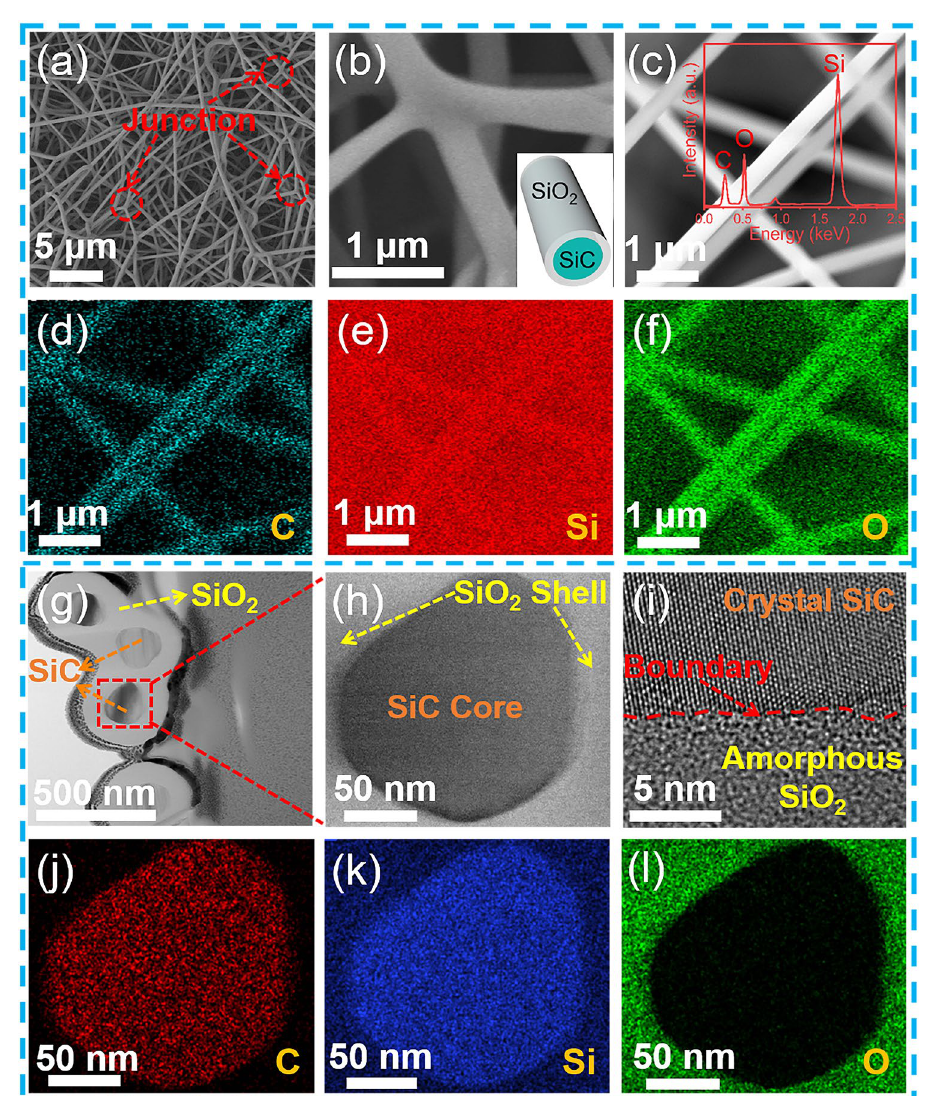
Fig. 2 Microscopic structure of the SiC@SiO 2 NFA. SEM images of a line cluster cross-linking microstructure of the SiC@SiO 2 NFA, b three cross-linked SiC@SiO 2 nanofibers to form a junction and a schematic of a SiC nanofiber coated with a nanolayer of SiO 2 (inset), c the SiC@ SiO 2 nanofibers with a smooth and round surface and the corresponding EDS spectrum for the nanofibers (inset), and d–f the corresponding EDS mappings from c . TEM images of g the SiC@SiO 2 nanofibers cross section with a core−shell structure, h a SiC@SiO 2 nanofiber cross sec- tion at magnification, i boundary between the SiC and SiO 2 , and j–l the corresponding element mapping for